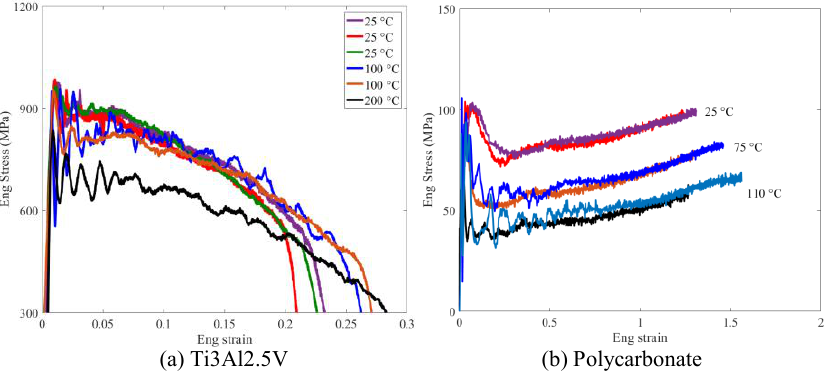
Fig.3 Engineering stress-strain relationship at high strain rates and elevated